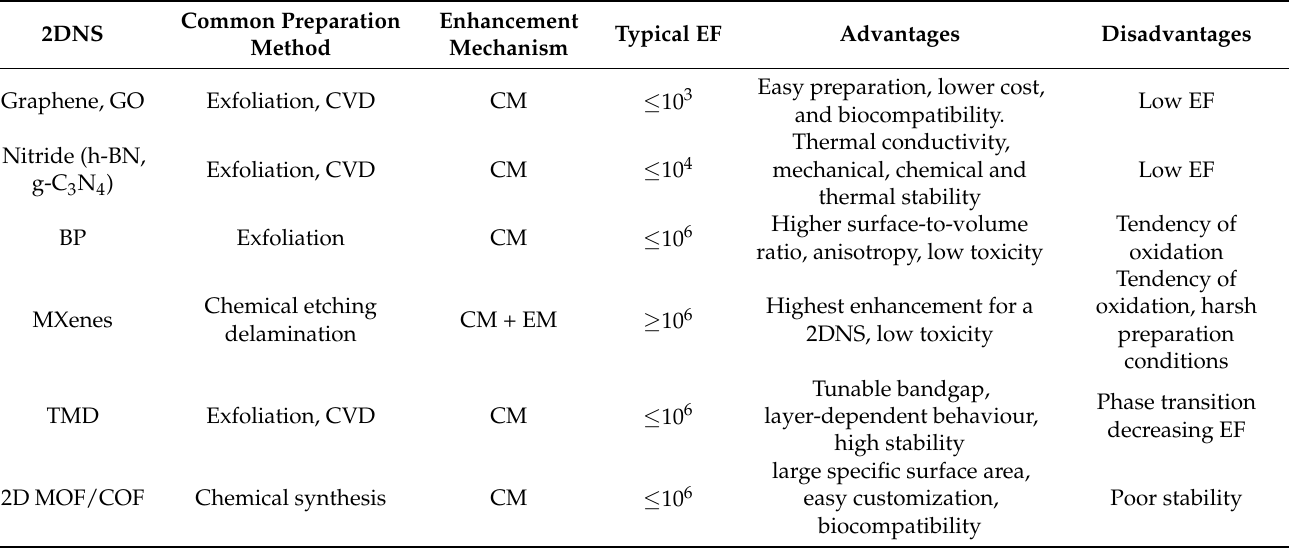
Table 3. Overview of different 2D nanomaterial SERS